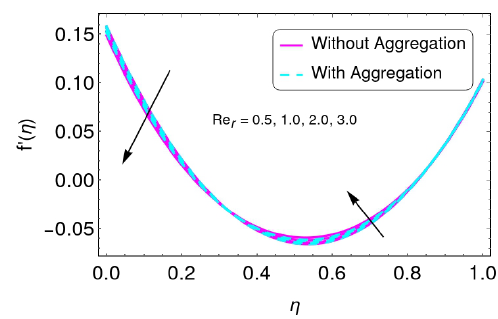
Figure 10. Characteristics of Re r for f (cid:48) ( η ) .